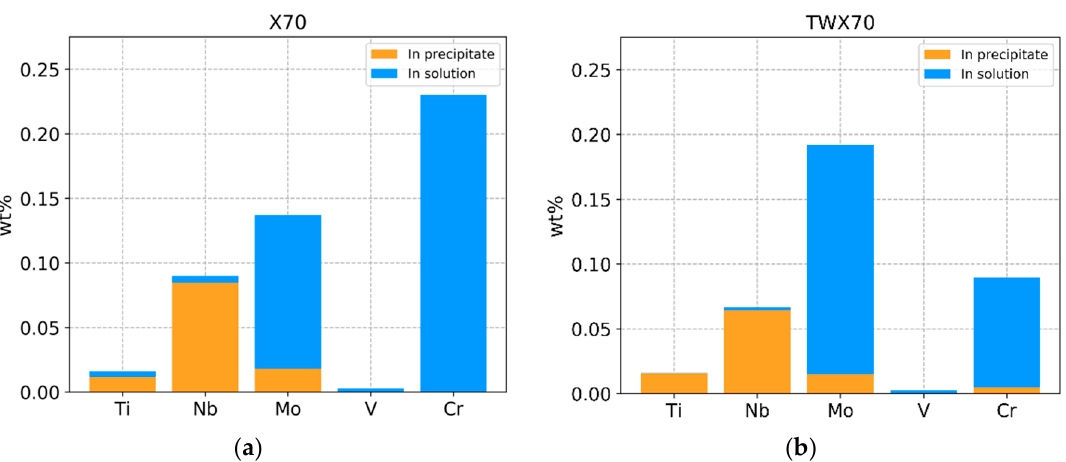
Figure 1. Composition in (wt %) of each element either in solid solution or in precipitate form for ( a ) X70 steel and ( b ) TWX70.